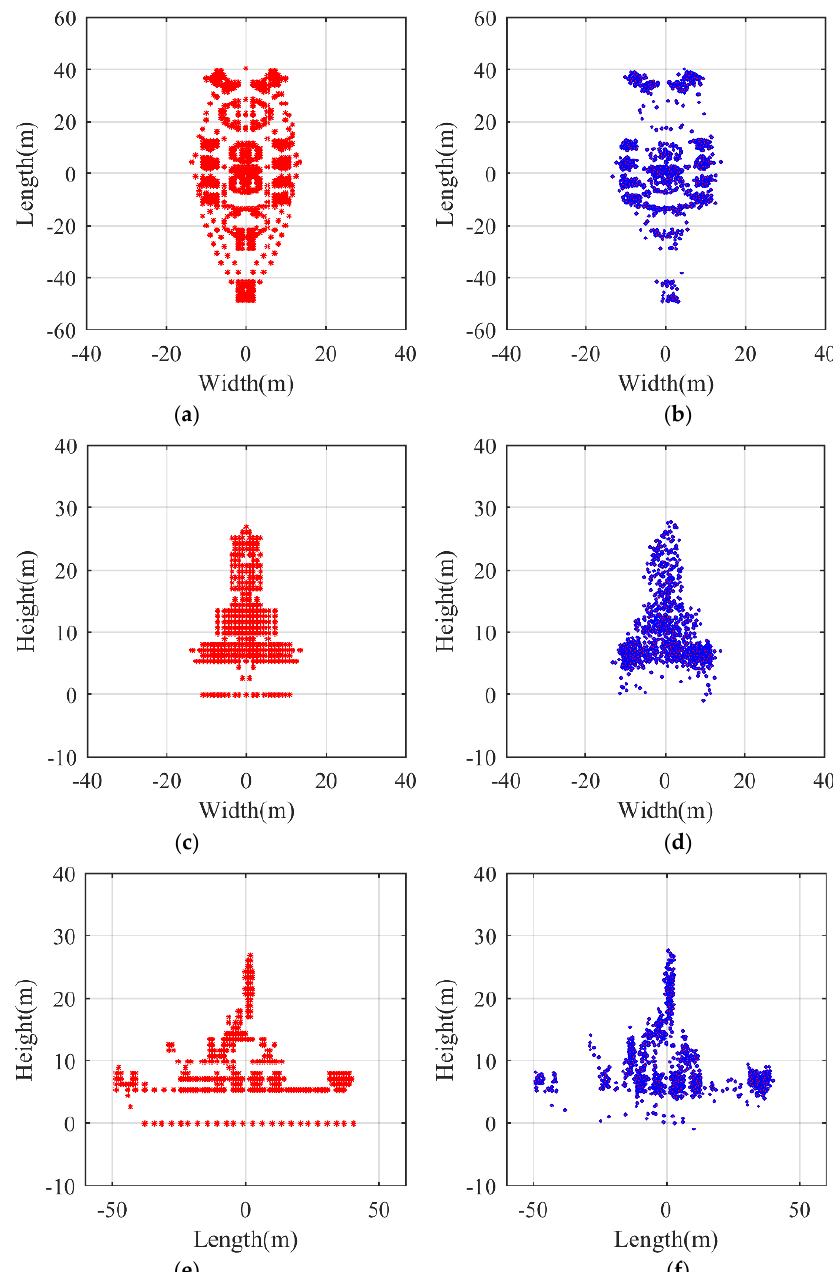
Figure 17. Model and reconstructed results using the proposed method. ( a ) Range–horizontal direction view of ship model. ( b ) Range–horizontal direction view of reconstructed result. ( c ) Range–vertical direction view of ship model. ( d ) Range–vertical direction view of reconstructed result. ( e ) Vertical–horizontal direction view of ship model. ( f ) Vertical–horizontal direction view of reconstructed result.